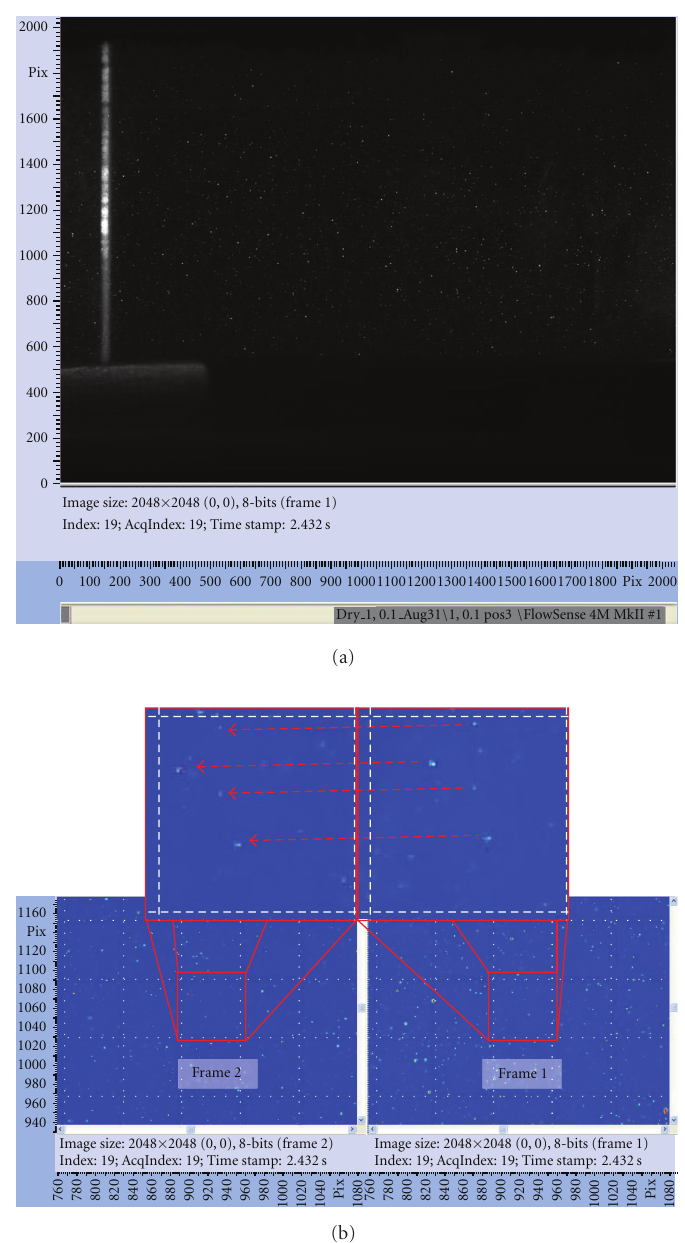
Figure 5: Raw data image (a); zoomed-in and color-enhanced view of corresponding interrogation regions from frames 1 and 2 showing particle displacement